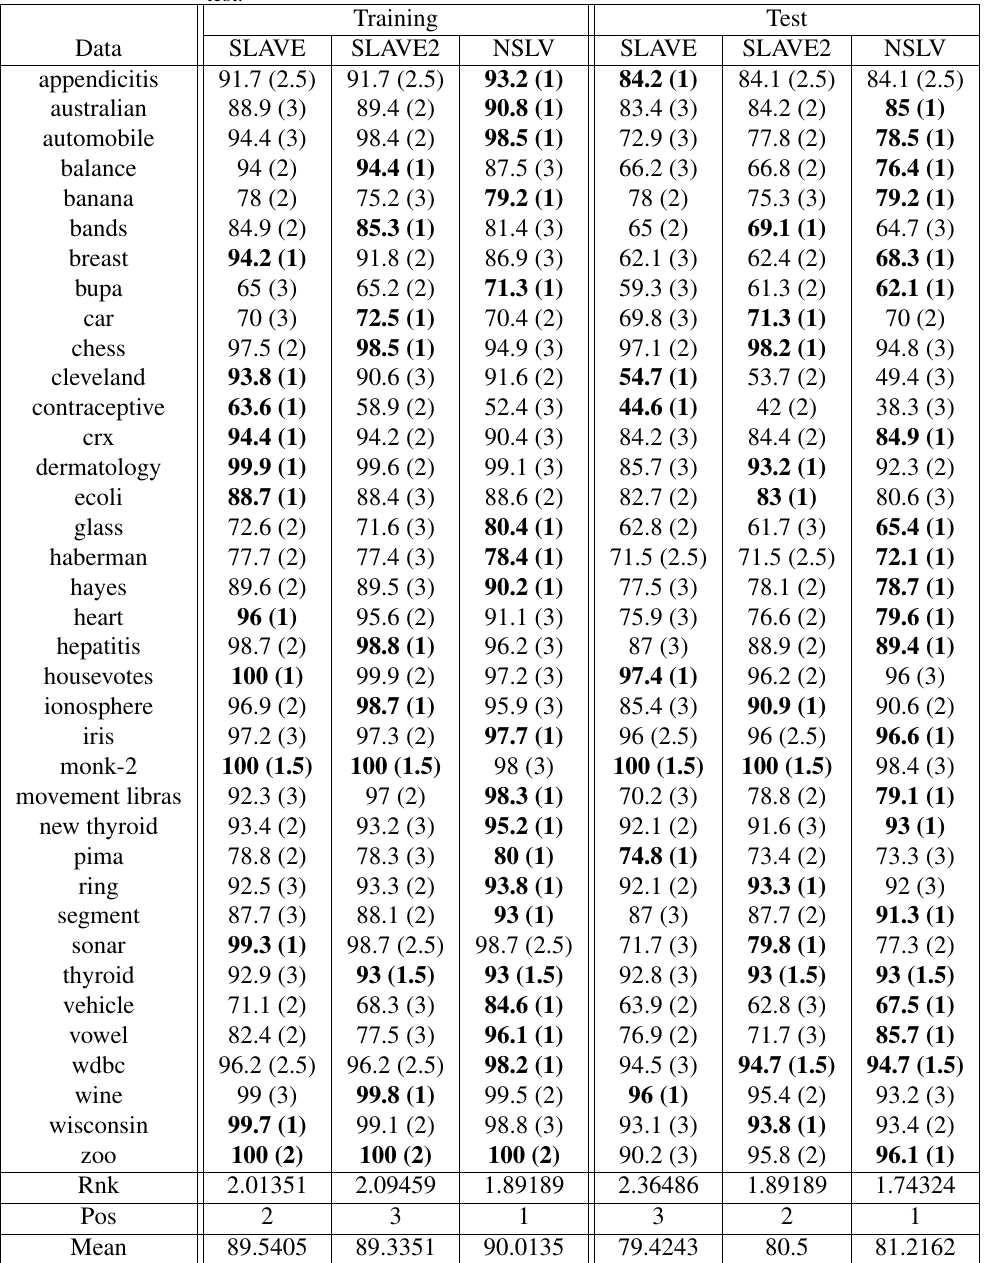
Table 5. Results obtained by SLAVE, SLAVE2, and NSLV on 37 databases. The Table shows the accuracy on training and